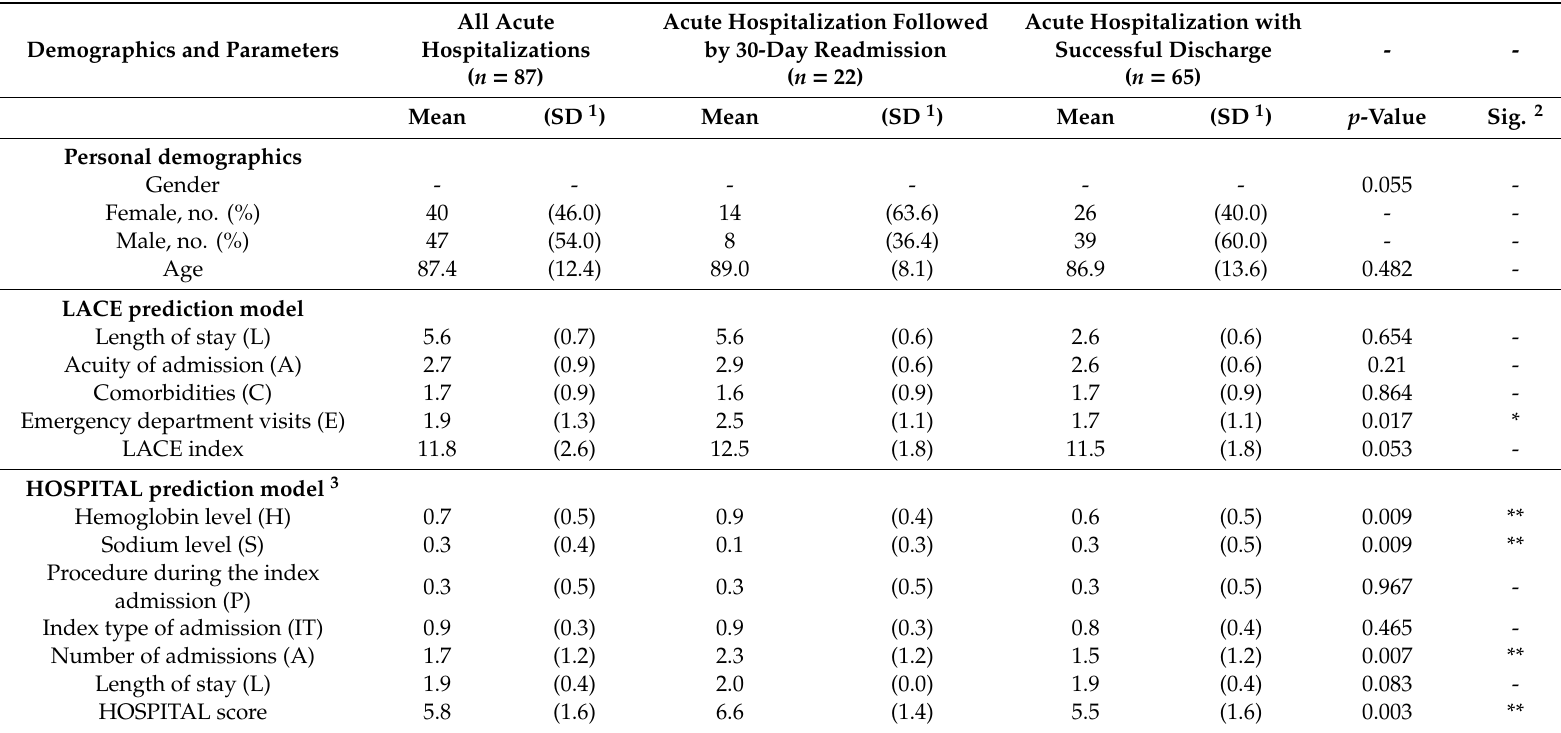
Table 1. Demographic information and parameters used in the LACE and HOSPITAL prediction models by outcomes of acute hospitalization of a home care patient cohort of a medical center a ffi liated home care unit in Taiwan, 2017 ( n = 87).